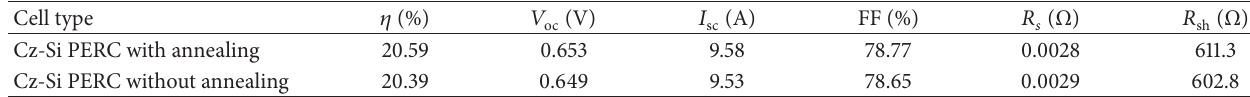
Table 5: Efficiency improvement of Cz-Si PERC after annealing.